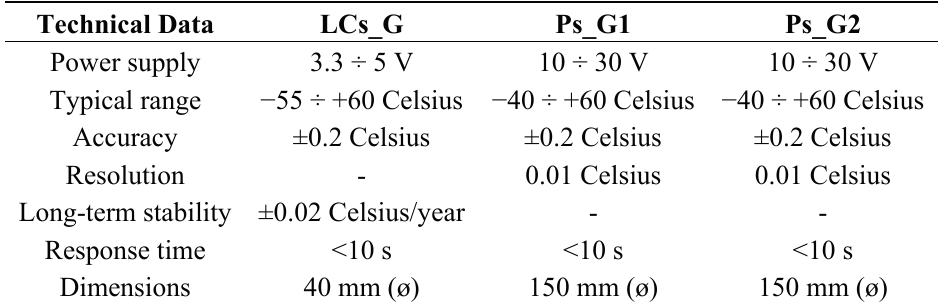
Table 5. Technical specifications sensors used to measure radiant temperature.